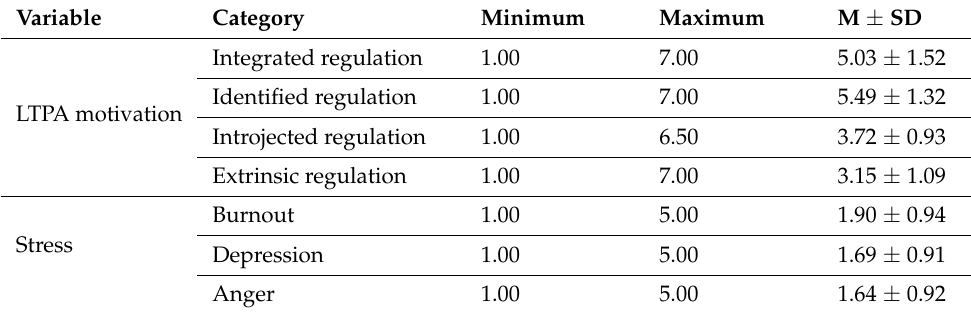
Table 4. Descriptive statistical analysis on LTPA motivation and